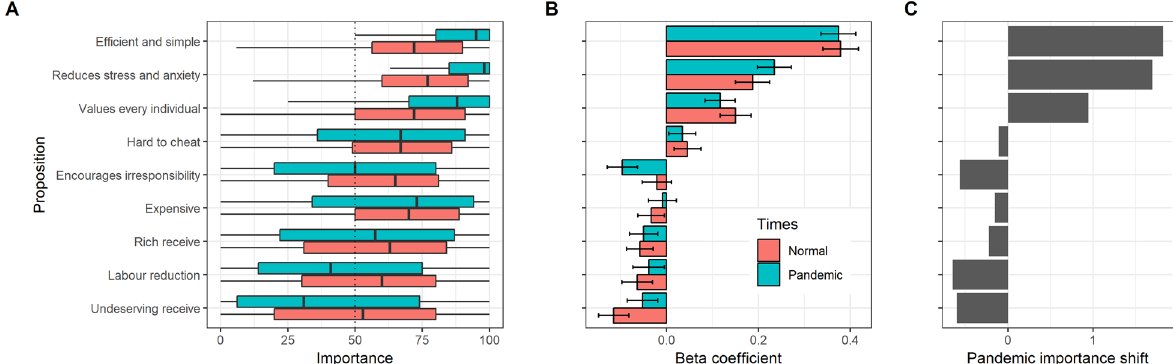
Fig. 2 Reasons for supporting UBI, study 1. A Boxplots of the rated importance of the UBI-related propositions, for normal (red) and pandemic (green) times. B Regression coef fi cients (standardised betas) predicting support for UBI from rated importance of nine UBI-related propositions. The model was estimated separately for the normal-times data (red), and the pandemic-times data (green). Error bars show ±1 standard errors. B Shift in the importance of each proposition when comparing pandemic times to normal times. Shift is expressed in terms of Cohen ’ s d (mean shift expressed in units of its standard